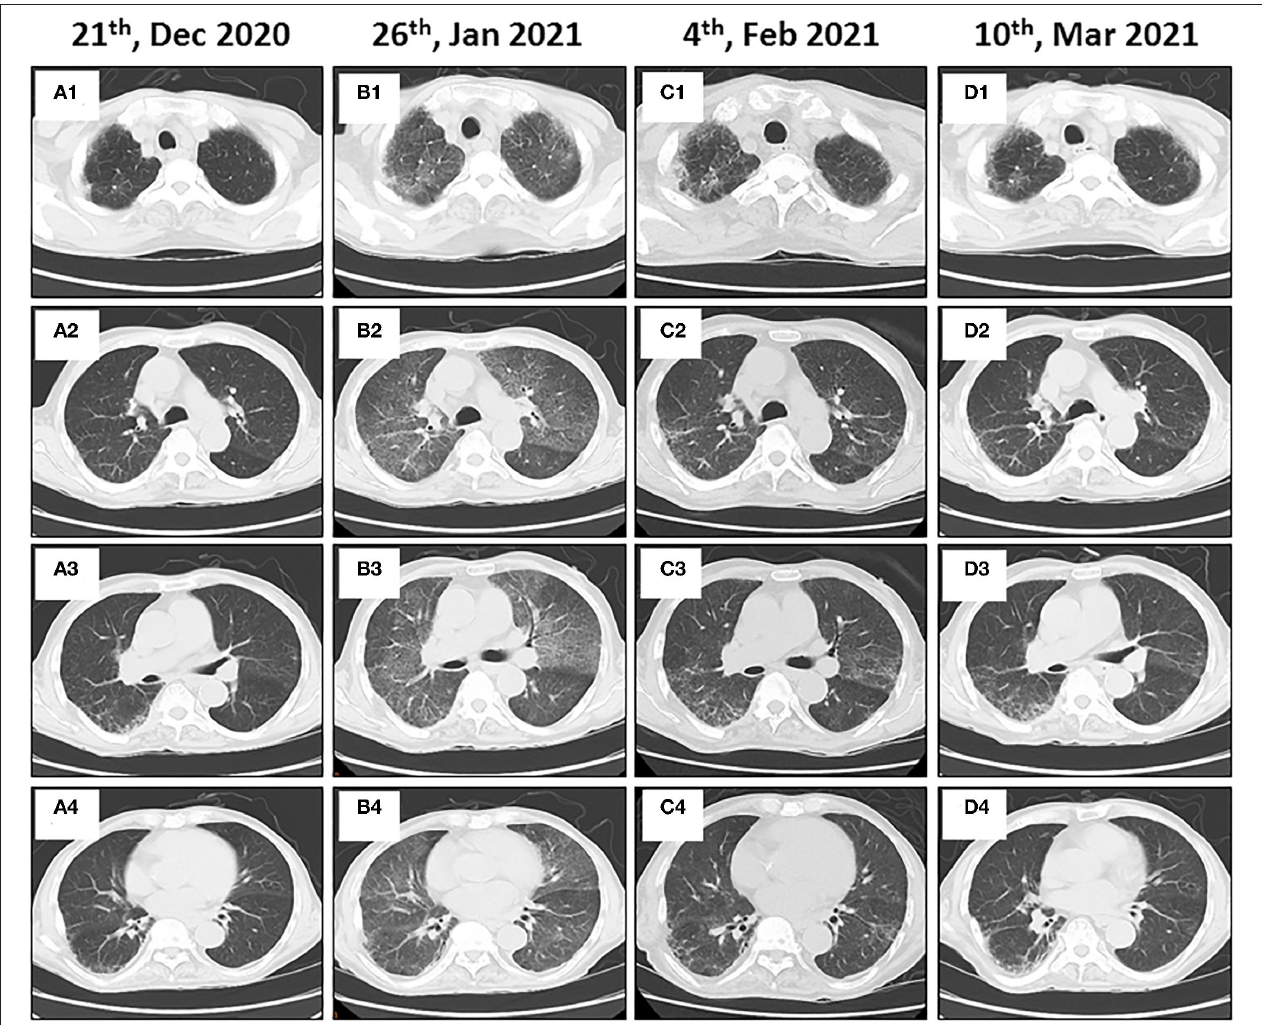
FIGURE 4 | Immune-related pneumonitis in a patient with metastatic gastric cancer and rare severe immune-related cholestatic hepatitis and subsequent severe late-onset pneumonia after pembrolizumab therapy. Baseline chest computed tomography (CT) images show the lungs before starting immunotherapy (A1–A4) . Follow-up axial CT images obtained 4 months after administering the pembrolizumab therapy showing non-specific interstitial pneumonia (B1–B4) . Immunotherapy was halted, and steroid therapy was administered. Follow-up chest CT images show near complete resolution of pneumonitis (C1–C4) . Chest CT images obtained after the steroid therapy was discontinued for 5 weeks (D1–D4)